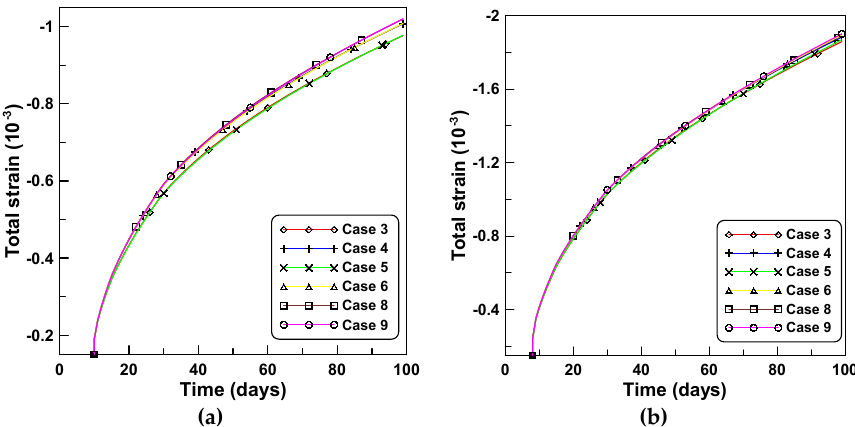
Figure 9. Total strains according to six constitutive formulations: ( a ) analysis of case A and ( b ) analysis of case B.